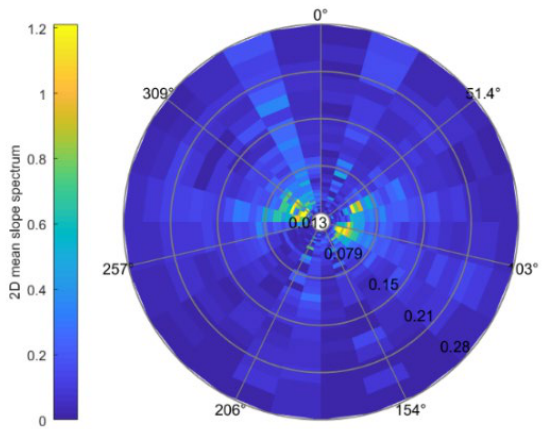
Figure 3. Wave spectrum of wave spectrometer.